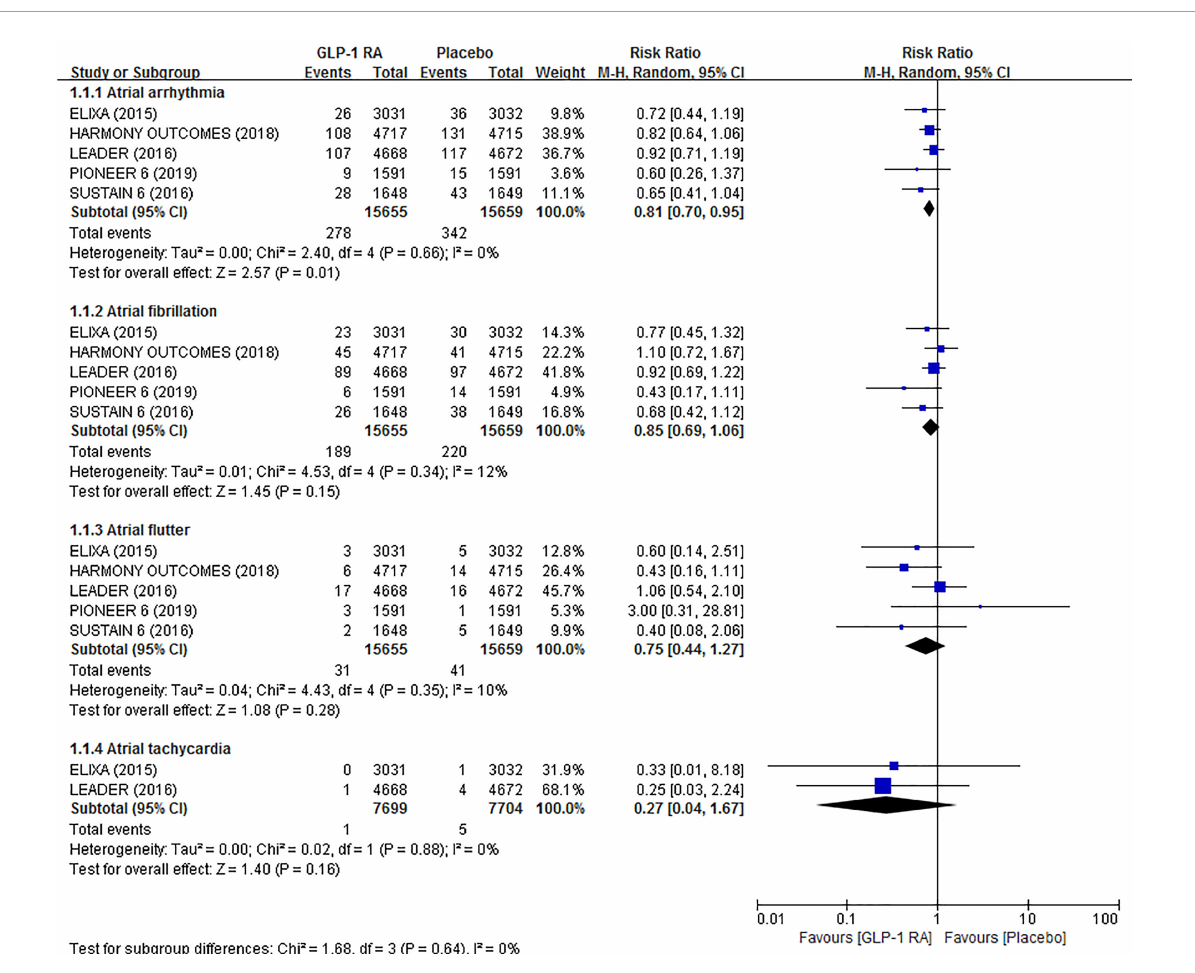
FIGURE2 Forest plot of the association between GLP-1RAs and the risk of atrial arrhythmias compared with